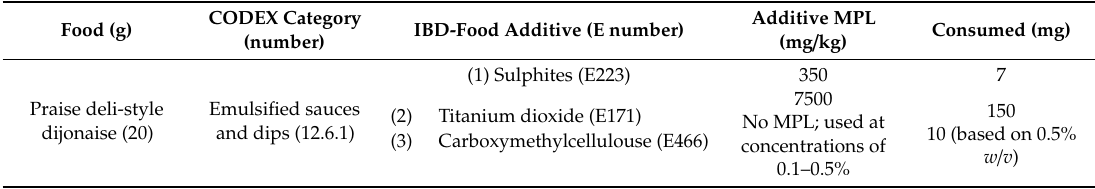
Table 7. An example of using CODEX to estimate maximum additive consumed in a